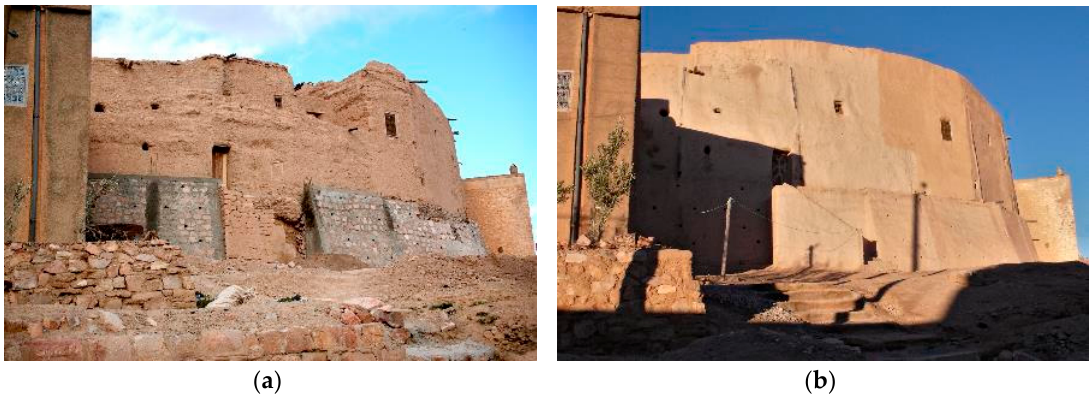
Figure 3. Restoration of the Tachaouite Ksar. ( a ) During the restoration work; ( b ) Final result.